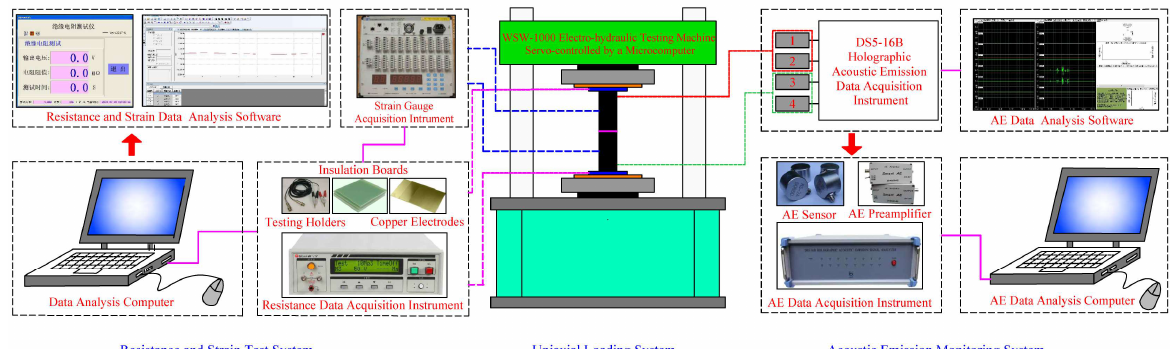
Figure 3. Experimental system.